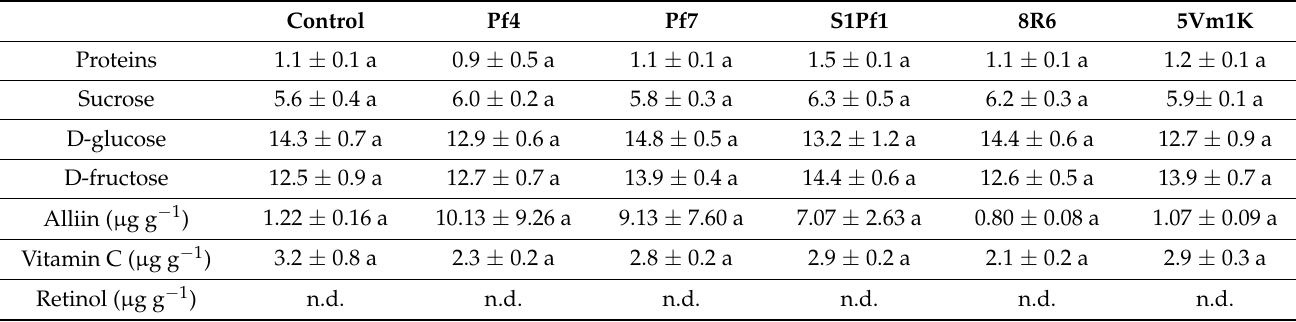
Table 4. The alliin, vitamin C, and retinol concentrations of the bulb of Allium cepa inoculated or not (Control) with different bacterial strains ( P. fluorescens Pf4, P. protegens Pf7, P. putida S1Pf1, P. migulae 8R6, and Pseudomonas sp. 5Vm1K). n.d. = not determined, the value was under the detection level for the method. Mean value ± standard error. Different letters in the row indicate significant differences among the treatments according to ANOVA followed by the LSD Fisher’s test ( p < 0.05).